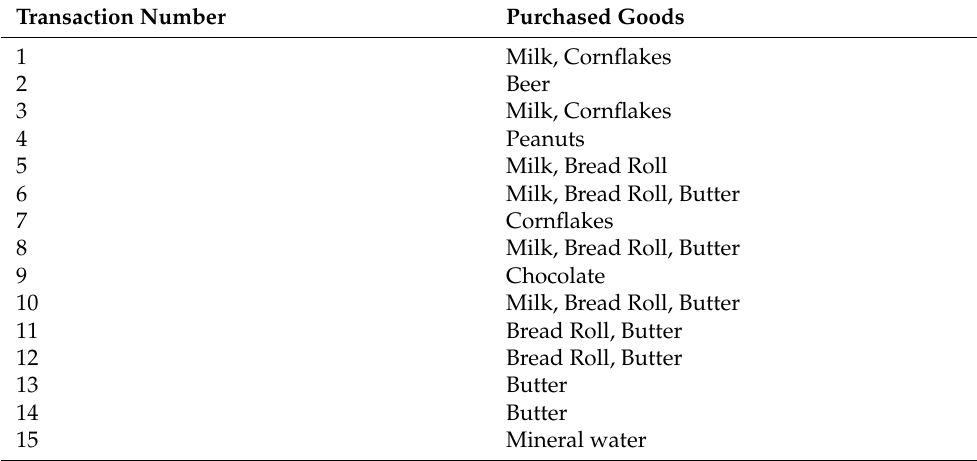
Table 1. Set of 15